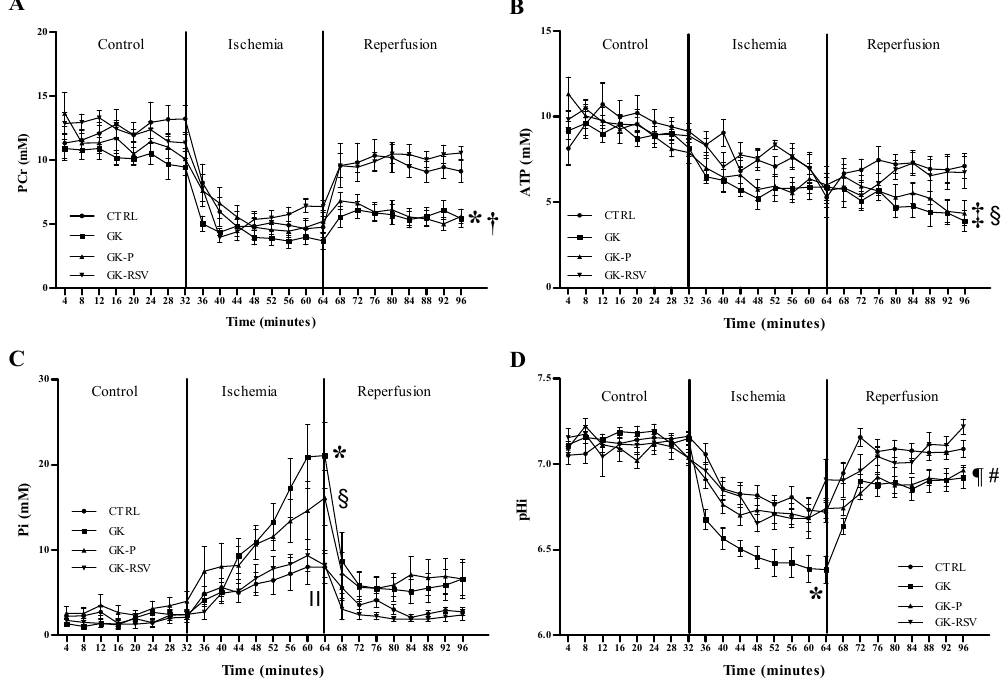
Figure 2. Kinetics of phosphocreatine (PCr) ( A ), ATP ( B ), Pi ( C ), and intracellular pH (pHi) ( D ) during the experimental time course in rat hearts. Data are expressed as means ± SEM. Two-way ANOVA was performed to observe the effect of group and time. * p < 0.01 GK vs. CTRL, † p < 0.01 GK-P vs. CTRL, ‡ p < 0.05 GK vs. CTRL, § p < 0.05 GK-P vs. CTRL, II p < 0.001 GK-RSV vs. GK, ¶ p < 0.05 GK-P